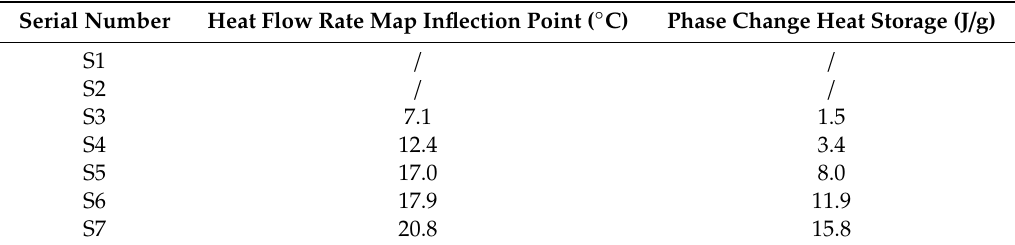
Table 3. S1–S7 heat flow diagram inflection point table.